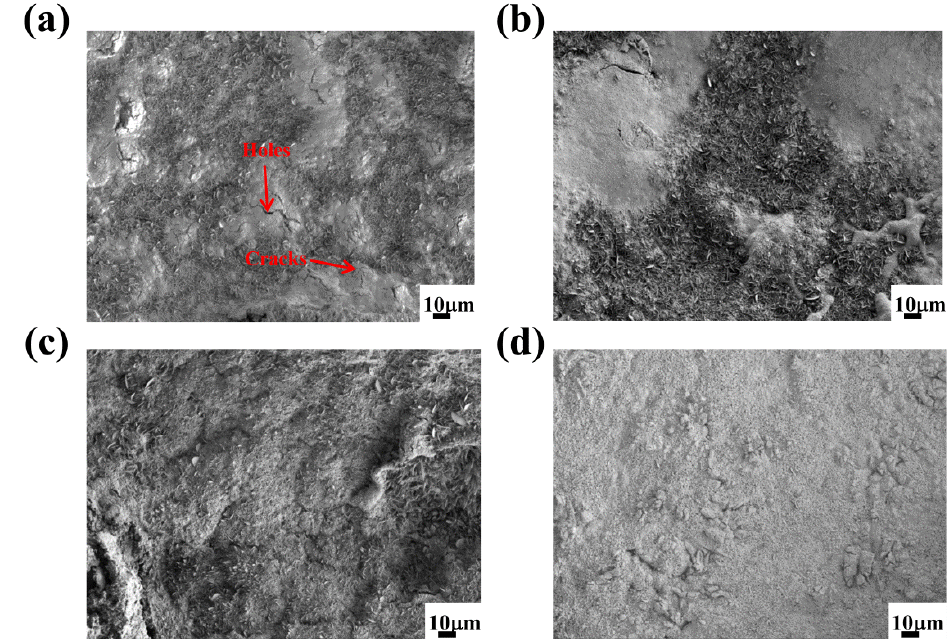
Figure 7. SEM micrographs of the Fe 2 B // sample surface of the scale formed by 100 h oxidation at 1073 K: ( a ) alloy A1, ( b ) alloy A2, ( c ) alloy A3, ( d ) alloy A4.